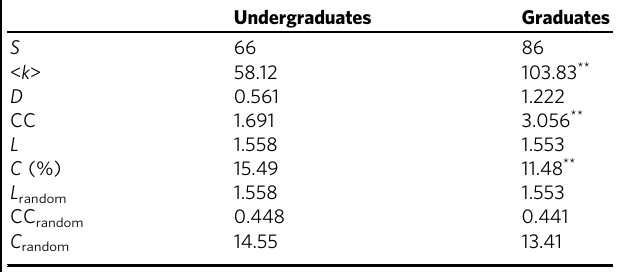
Table 3 An overview of macroscopic network measures of the three networks.